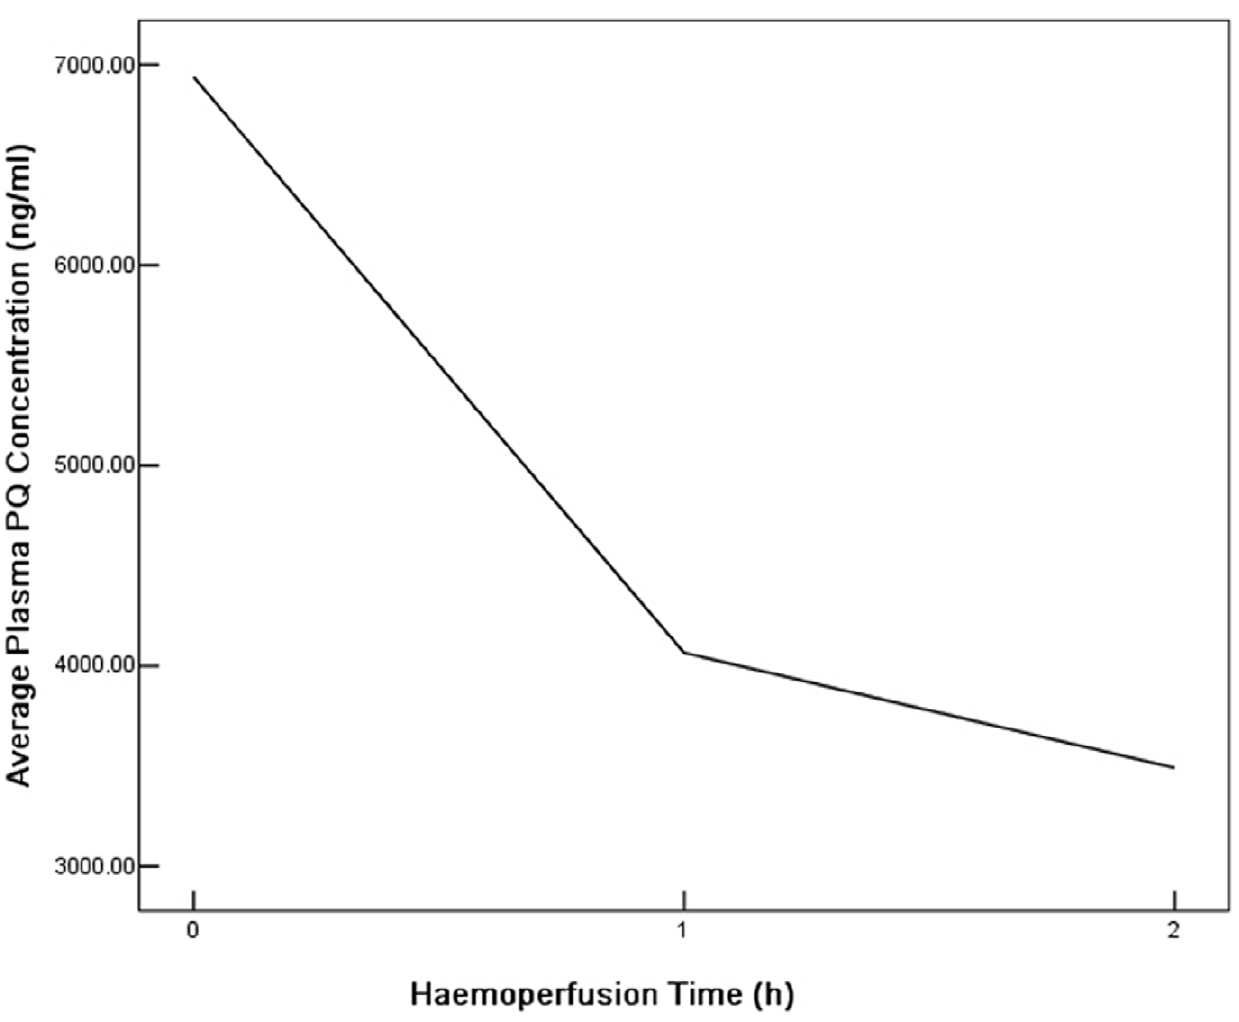
Figure 1. The change of average plasma PQ concentration as HP going on. The X axis stands for the treatment time of haemoperfusion (hour), while the Y axis stands for average plasma PQ concentration (ng/ml).